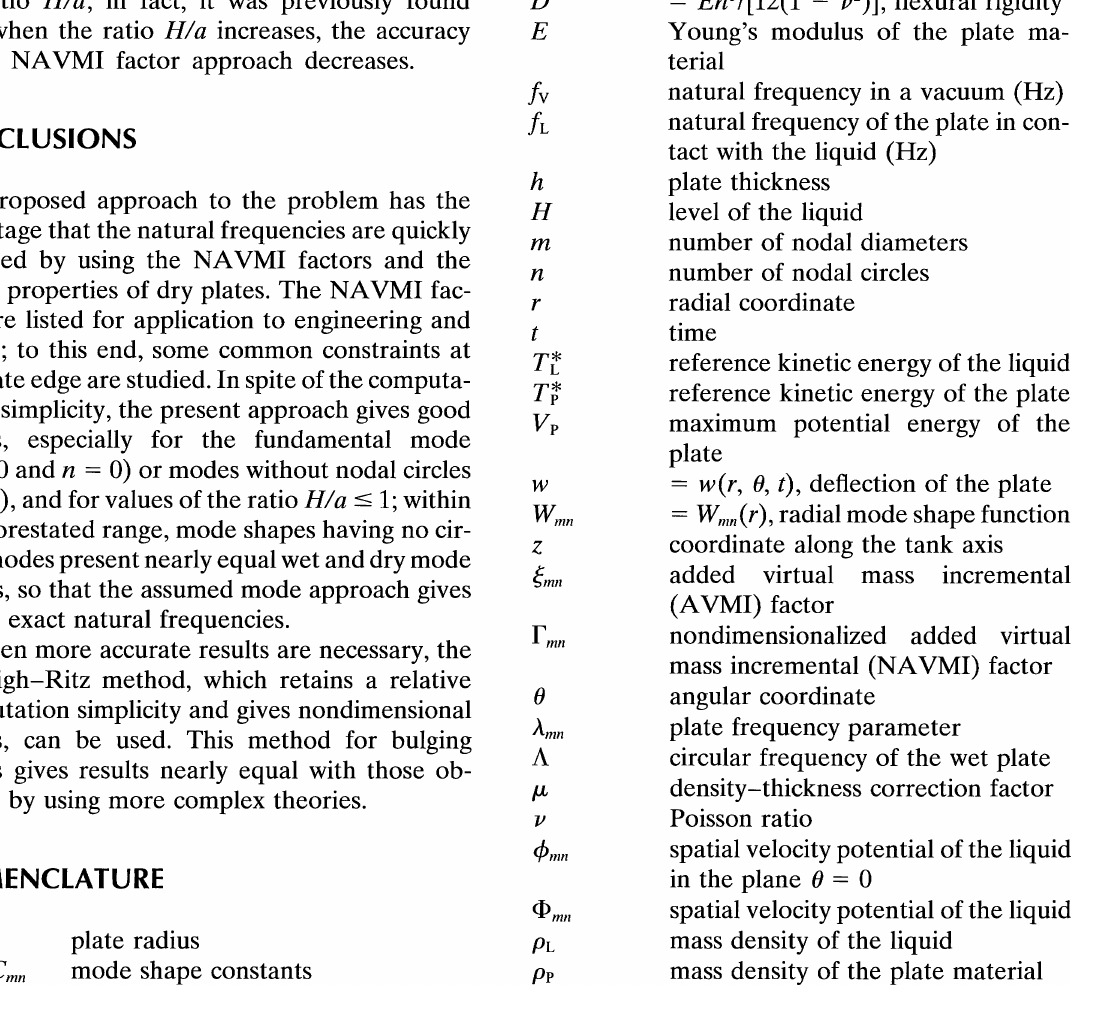
FIGURE 11 Comparison of (---) dry and (-) wet modes for clamped plates; modes with a nodal diameter (m = 1) and H/a =